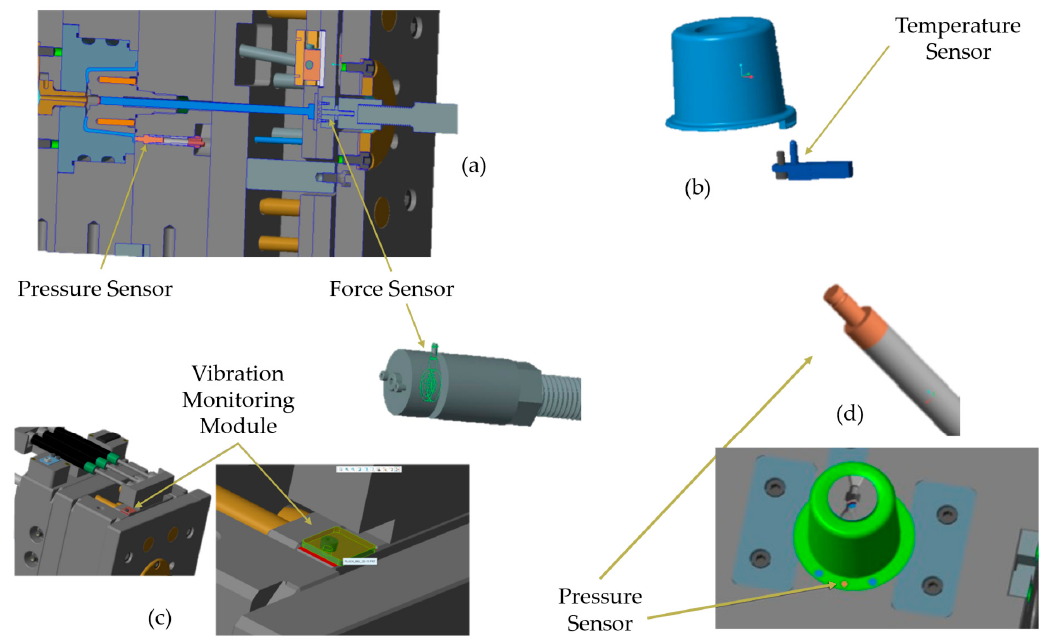
sensor installation detail; ( b ) Injected part 3D model and relative temperature sensor position; ( c ) Vibration monitoring module position; ( d ) Pressure sensor 3D model and its position relative to the